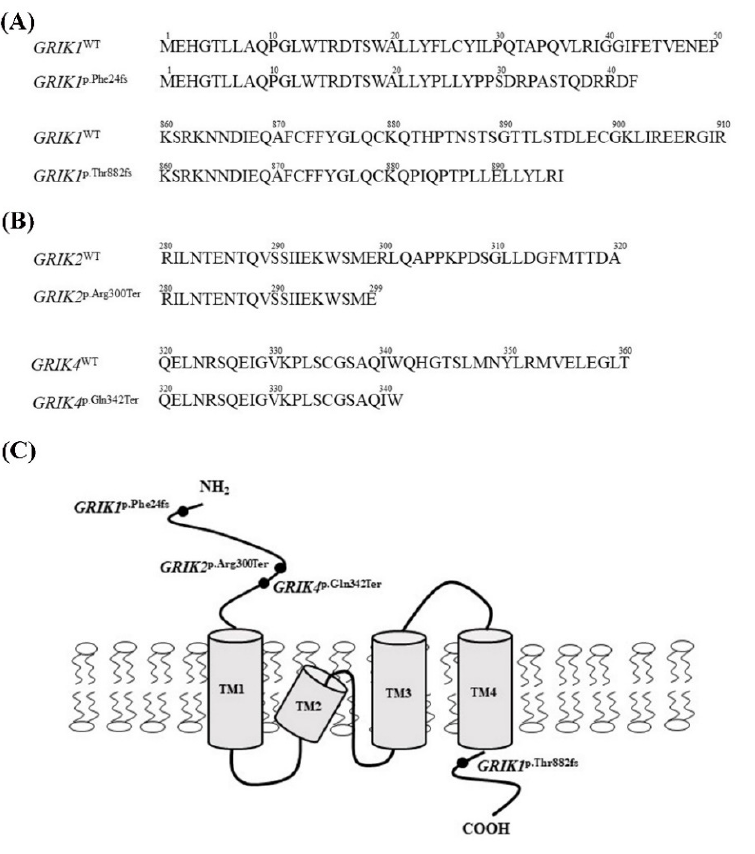
Figure 1. Four schizophrenia-associated and rare protein-truncating mutations identified in this study. ( A ) Schematic representation of the two frameshift mutants ( GRIK1 p.Phe24fs and GRIK1 p.Thr882fs ) of the GRIK1 . ( B ) Schematic representation of the two nonsense mutants ( GRIK2 p.Arg300Ter and GRIK4 p.Gln342Ter ) in GRIK2 and the GRIK4 , respectively. ( C ) Schematic representation of the kainate receptor structure and locations of the four rare protein-truncating mutations of the GRIK gene family. TM, transmembrane.